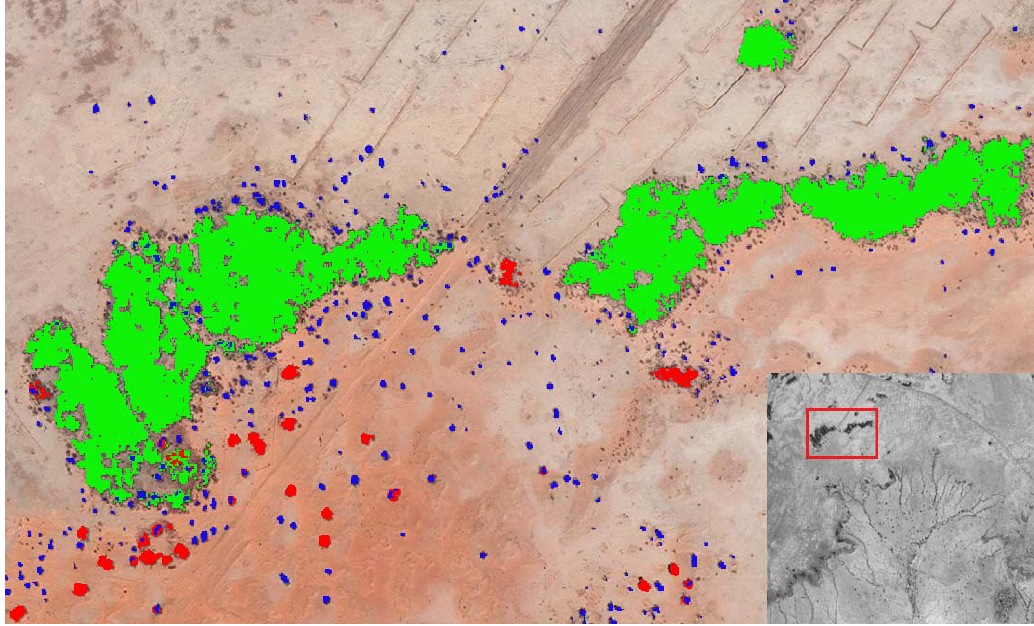
Figure 18. Sample of the original Digital Globe image and the resulting classification superposed. Tiger bush in white; isolated trees in red.